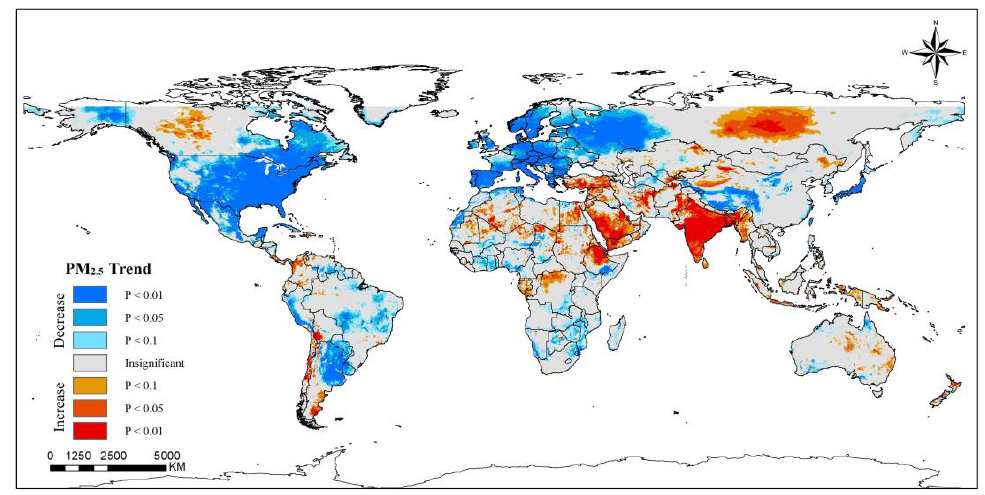
Figure 1. Spatiotemporal trends of PM 2 . 5 concentrations worldwide (2000 – 2019).